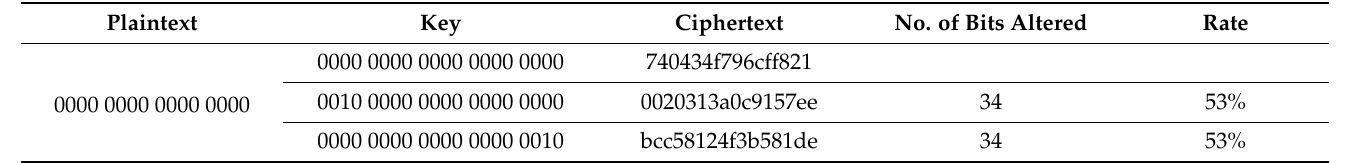
Table 8. The Effect of the Avalanche on SLA-80.